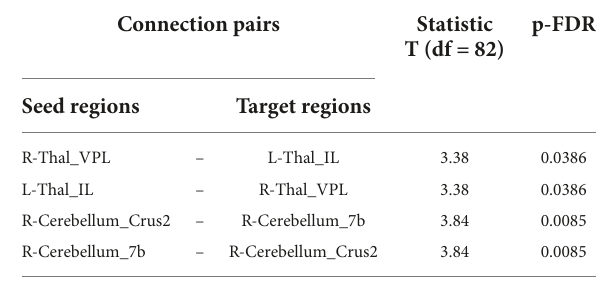
TABLE 4 Connected pairs showing significant differences in functional connectivity on HC < MDD